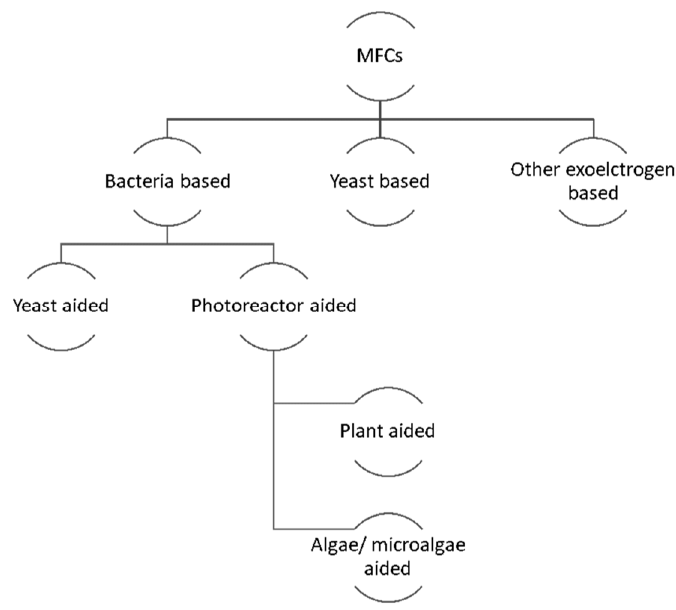
Figure 8. Classification of MFCs according to their catalytic activities.